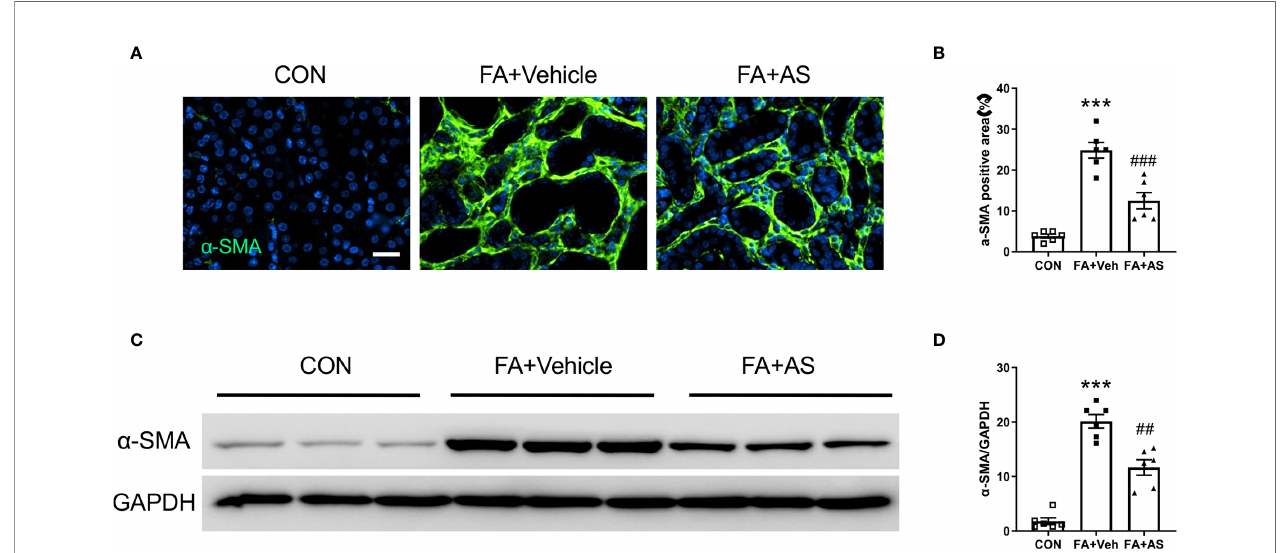
FIGURE 7 | AS1517499 reduces myo fi broblast formation in folic acid nephropathy. (A) Representative photomicrographs of kidney sections 2 weeks after vehicle or AS1517499 treatment stained for a -SMA (green) and counterstained with DAPI (blue). Scale bar, 50 m m. (B) Quantitative analysis of a -SMA positive area in the kidney. *** P < 0.001 vs CON; ### P < 0.001 vs FA+Veh. n = 6 per group. (C) Representative Western blots showing a -SMA protein levels in the kidney 2 weeks after vehicle or AS1517499 treatment. (D) Quantitative analysis of a -SMA protein expression in the kidney. *** P < 0.001 vs CON, ## P < 0.01 vs FA+Veh. n = 6 per